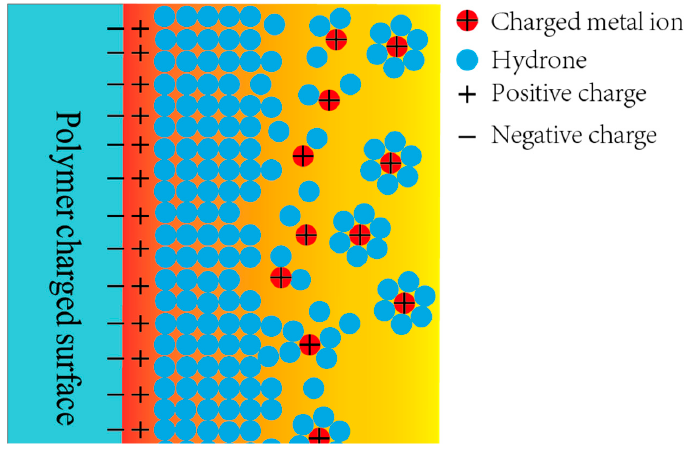
Figure 14. Reduction of the polymer hydration shell by metal ions.